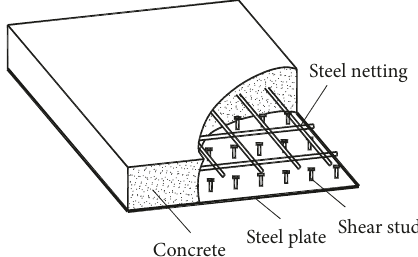
Figure 1: Steel plate-concrete composite